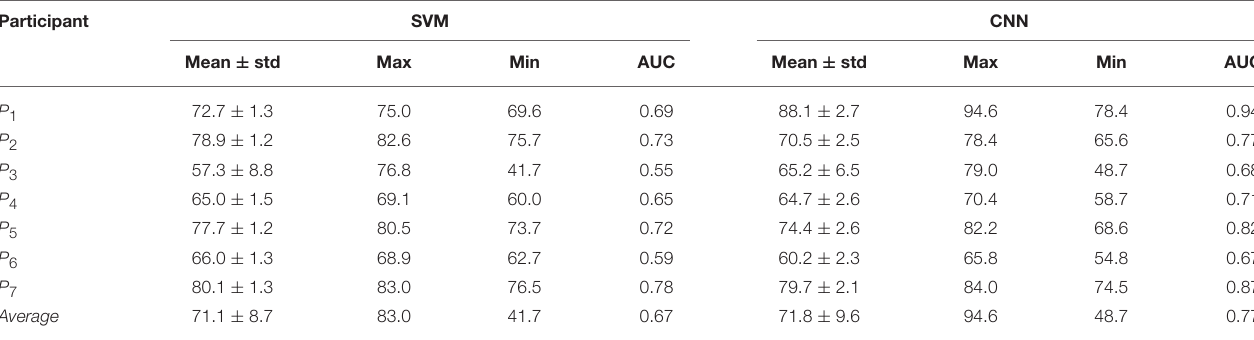
TABLE 3 | Summary of classification accuracy results for each participant ( P 1 to P 7 ) achieved with the SVM and CNN. Participant SVM